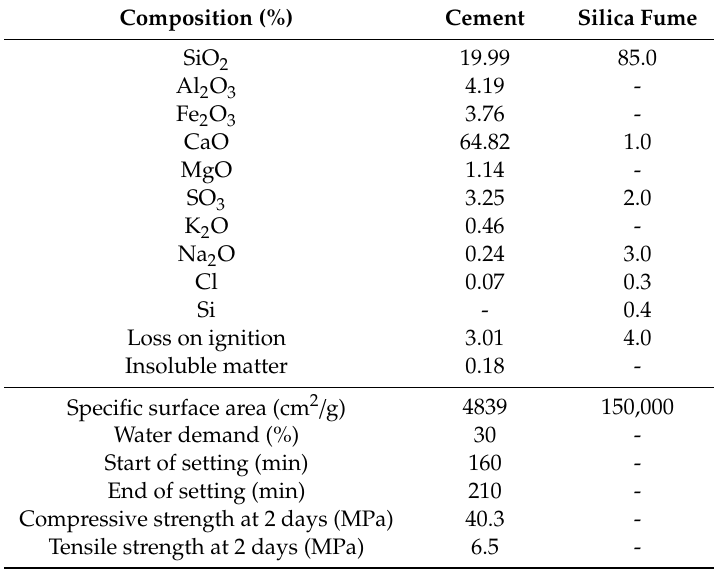
Table 1. Chemical compositions and physical properties of used cement and silica fume.